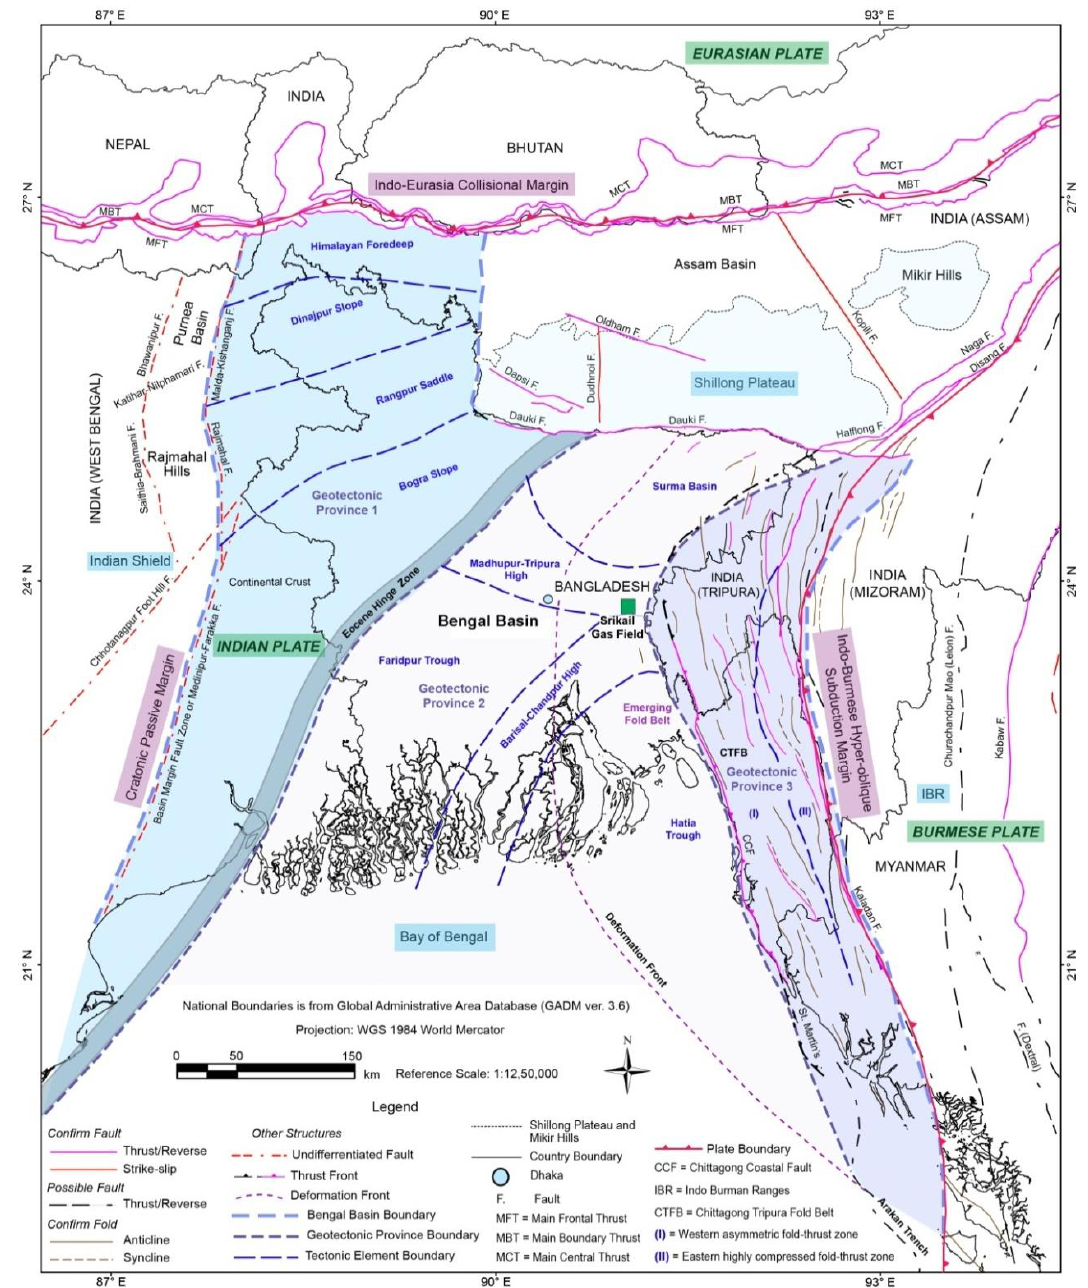
Figure 1. Simplified tectonic map of the Bengal Basin and its surroundings (modified after [1]) with the location of the Srikail Gas Field.